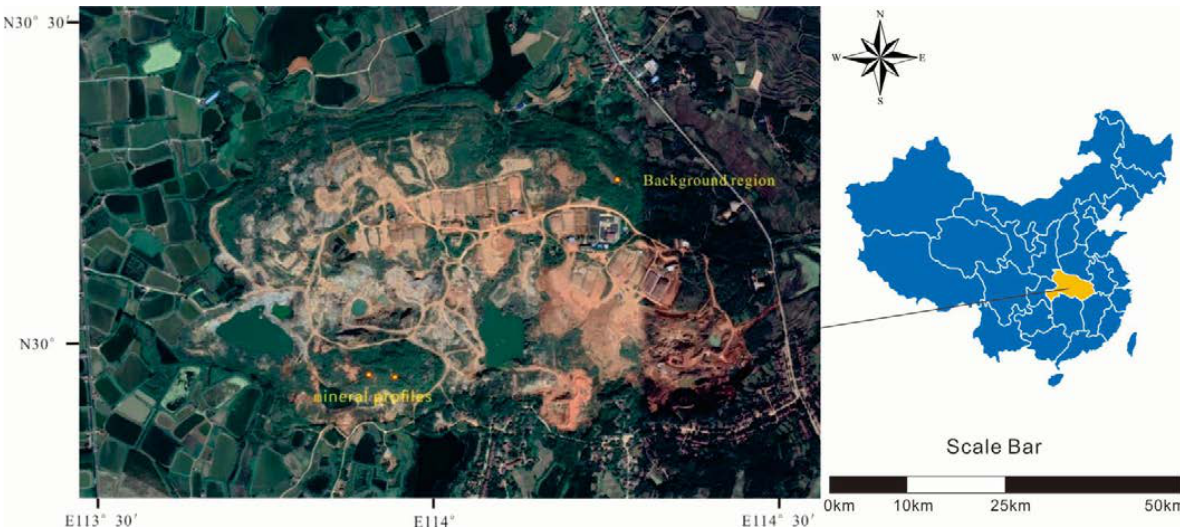
Figure 1. The sampling area in Shewushan gold deposit.